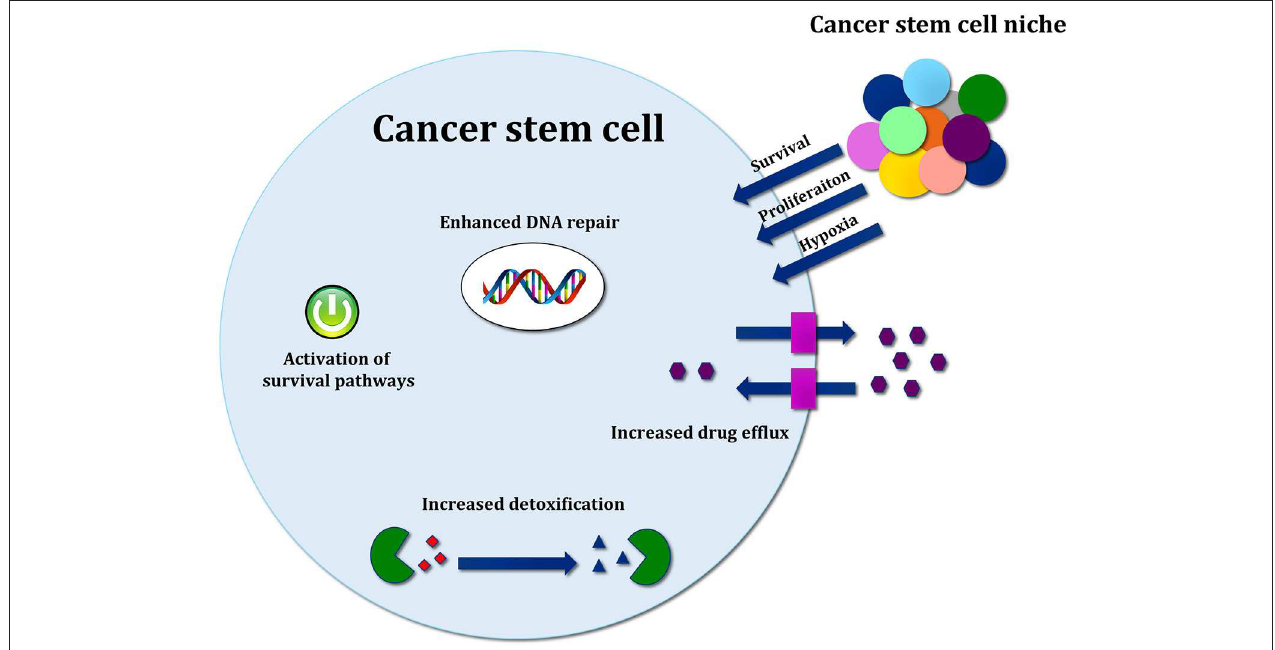
FIGURE 3 | Mechanisms of cancer stem cell resistance toward conventional therapy. Therapy resistance mechanisms include drug efflux by ABC transporters, increased detoxification by ALDH activity, efficient ROS scavenging, and activation of developmental pathways mediating survival. Signals released by cancer stem cell (CSC) niche are also important to support survival, proliferation and therapy